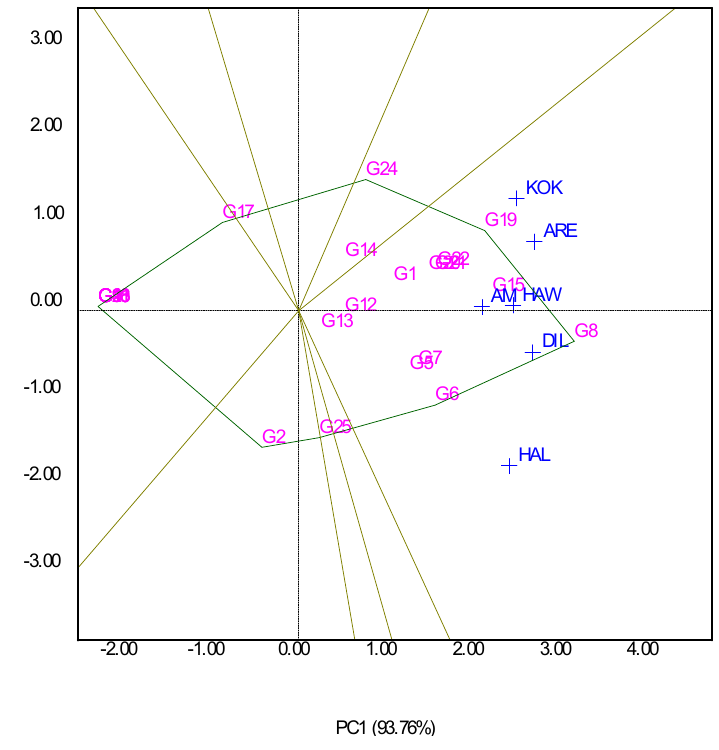
Figure 3: GGE-biplot showing environments and respective sweetpotato genotypes for β-carotene